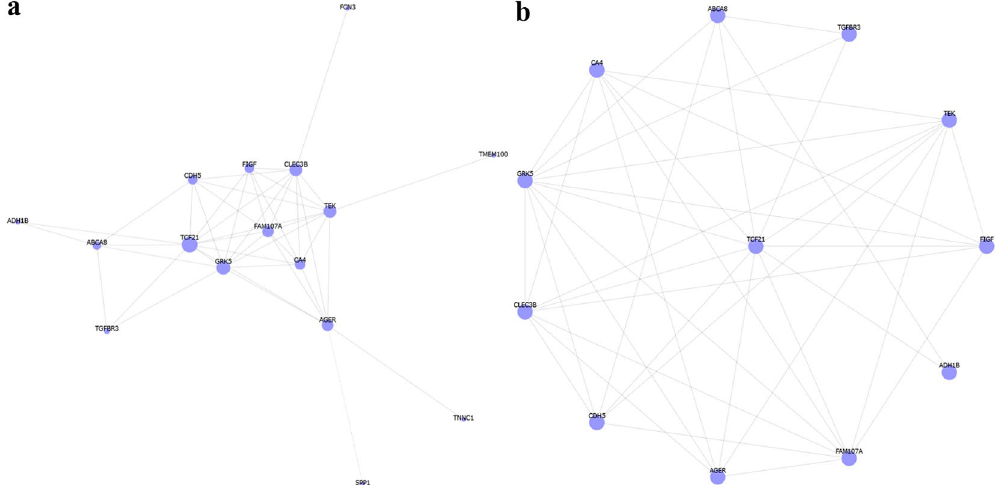
Figure 5. Gene co-expression network of the DEGs that eliminated gender differences for GSE10072. ( a ) The gene co-expression network. ( b ) The sub-graph shows that TCF21 has the most gene connections in the gene co-expression network.